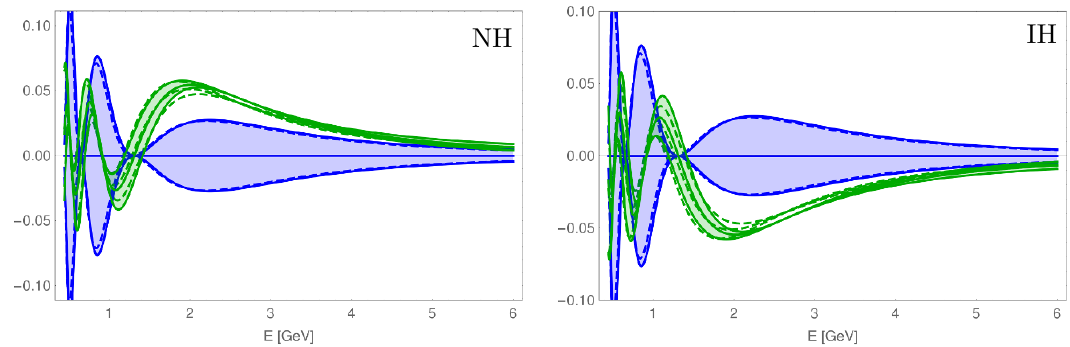
Figure 3 . CPT-odd (green) and T-odd (blue) components of A CP as functions of the neutrino (cid:22)e energy E through the Earth mantle (of constant density) and a baseline of L = 1300 km. Both the exact (dashed) and the analytical (solid) results from eqs. (3.25) are shown. Normal/Inverted Hierarchy in the left/right pannel. The bands correspond to all possible values changing (cid:14) in (0 ; 2 (cid:25) ); the upper/central/lower lines for A CPT ( A T ) correspond to cos (cid:14) (sin (cid:14) ) = (cid:0) 1 ; 0 ; (cid:22)e (cid:22)e